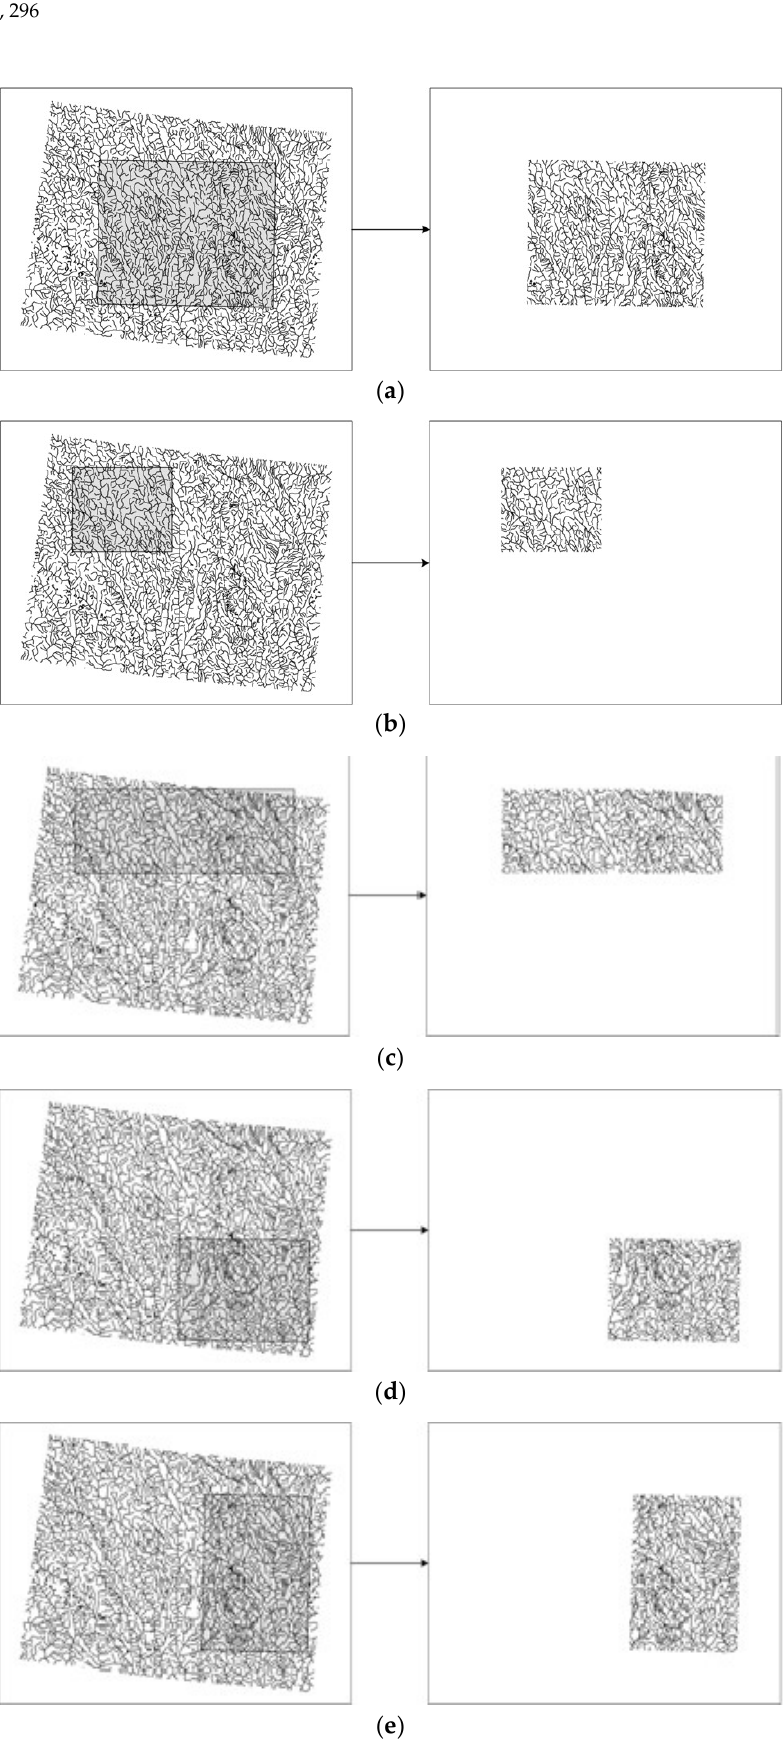
Figure 10. The different cropping attacks employed in our experiments.